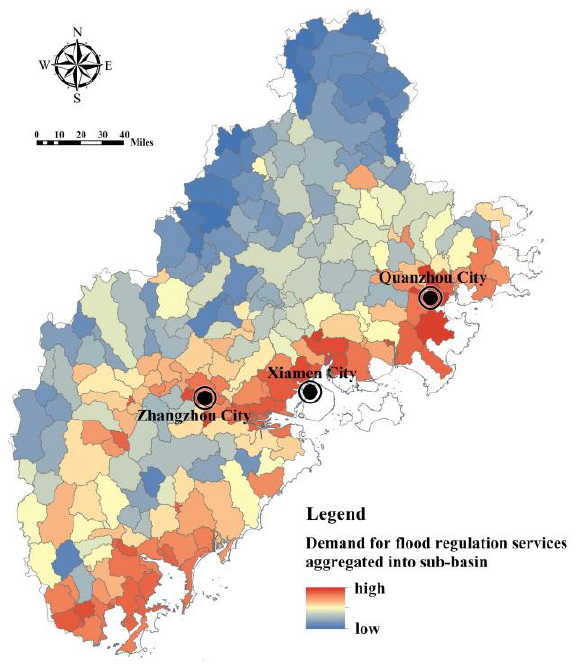
Figure 13. The demand of FRES converging to sub-basins of Fujian Delta.